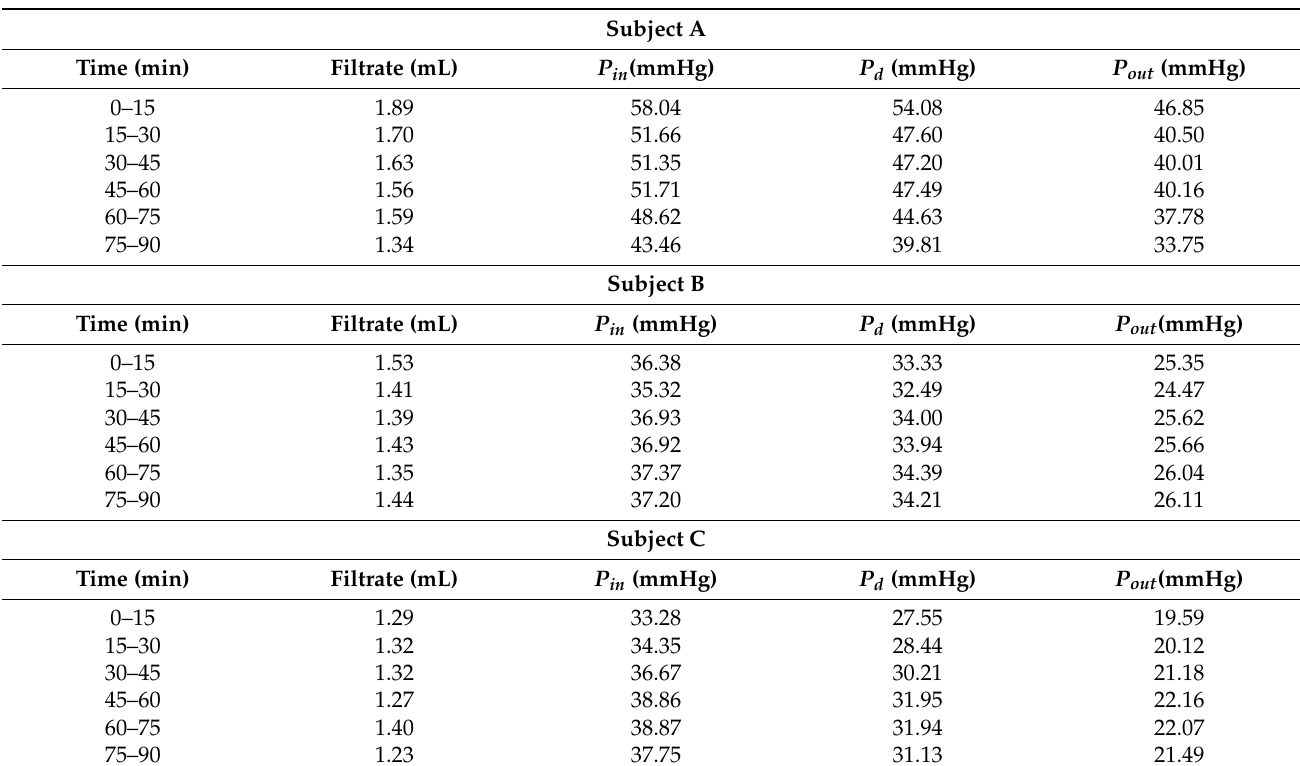
Table 2. Pressure and amount of filtrate during the